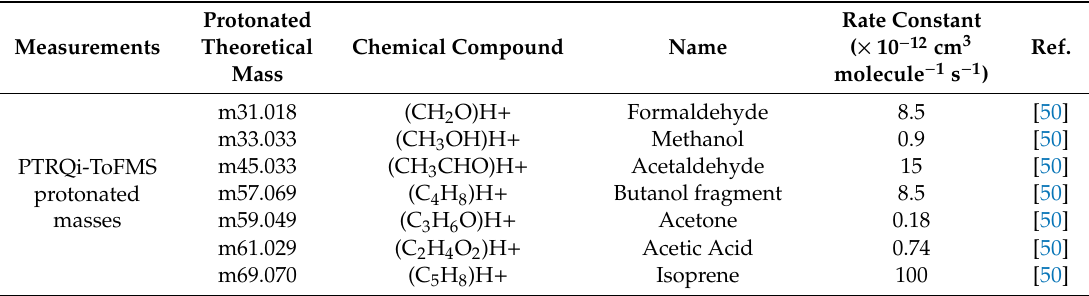
Table 2. List of selected compounds used for OH reactivity calculations with their respective k i-OH at 298 K and 1